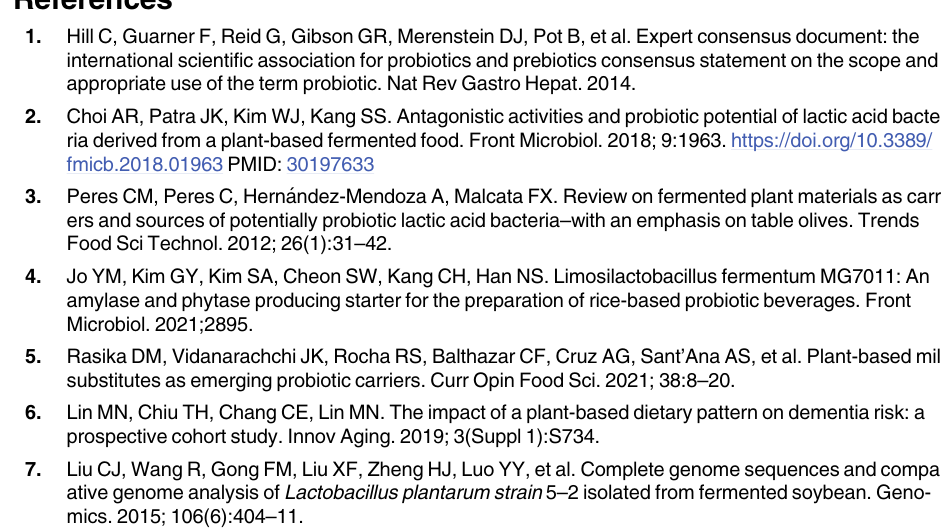
tional categories were presented on the right part of the figure with blanket which shows num- ber of genes and percentage. S1 Table. Antimicrobial resistance genes determined by CARD database and ResFinder sever 4.1. S2 Table. Comparison of enzyme related with carbohydrate utilization between Lactiplan- tibacillus plantarum PMO 08 and Lp . plantarum